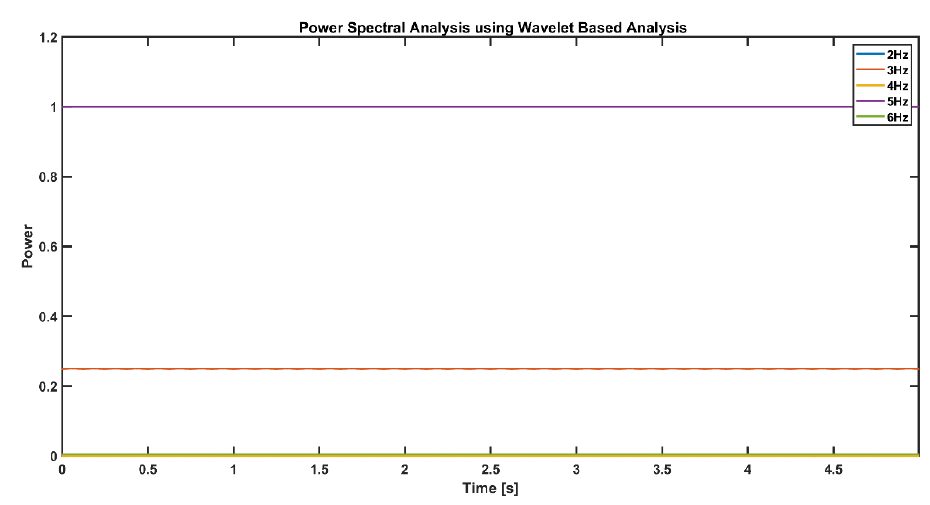
Figure 11. Frequency power of the 5-Hz signal component is 1, and that at 3 Hz is 0.25 throughout the time in the simulated signal.